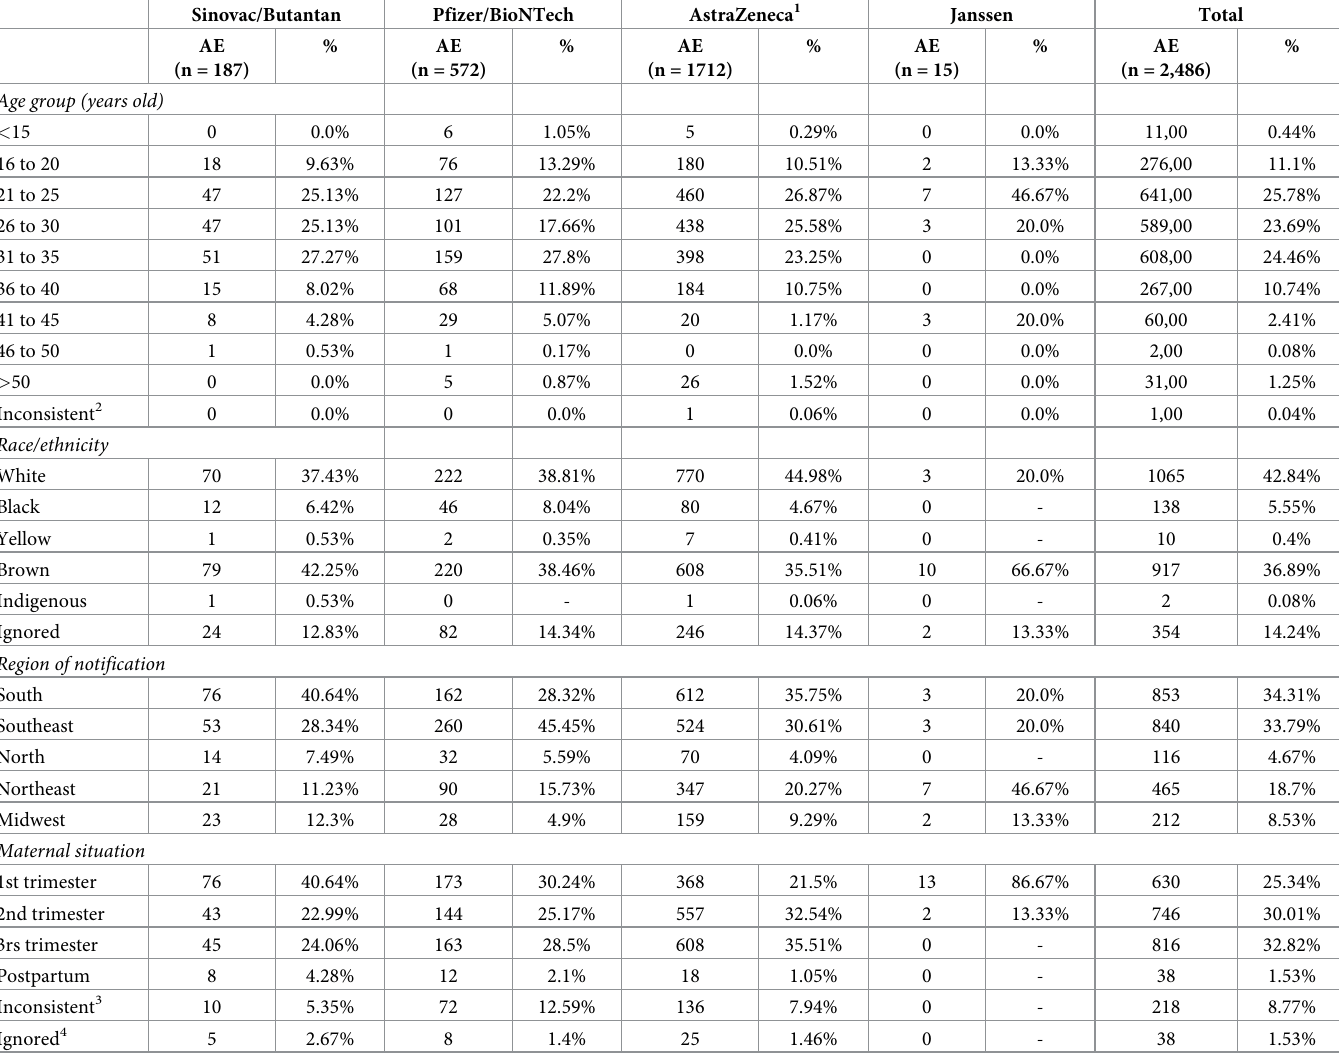
Table 1. Sociodemographic characteristics of pregnant and postpartum women that notified adverse events after receiving vaccines against COVID-19.